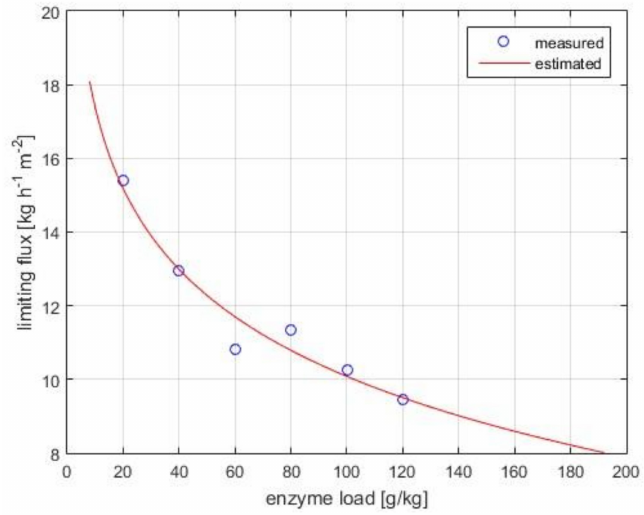
Figure 3. Limiting flux versus bulk enzyme concentration in the pressure-independent zone. Operational conditions: 4 bar, 30 w / w % lactose concentration, pH 6.0, 50 ◦ C, 0.18 m 3 · h − 1 crossflow rate, 10 kDa UF membrane. Measured and estimated (using Equation (1)) data are illustrated with symbols and continuous lines,